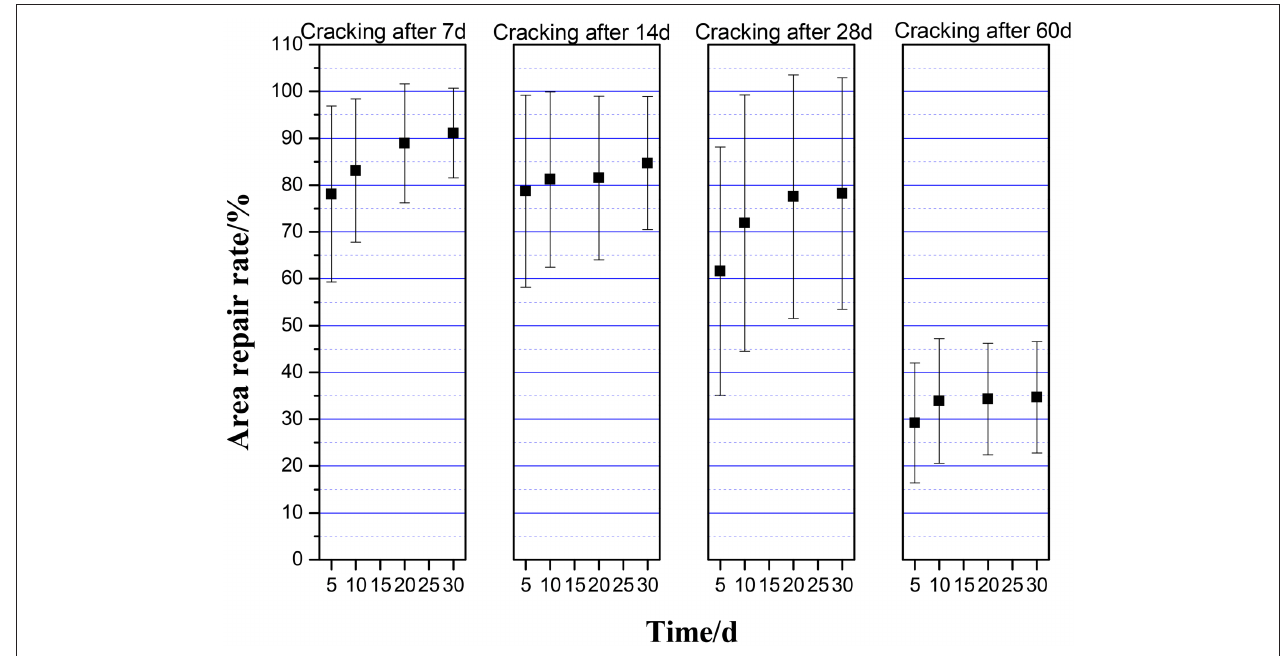
FIGURE 11 | The average area repair rate of cracks under different cracking